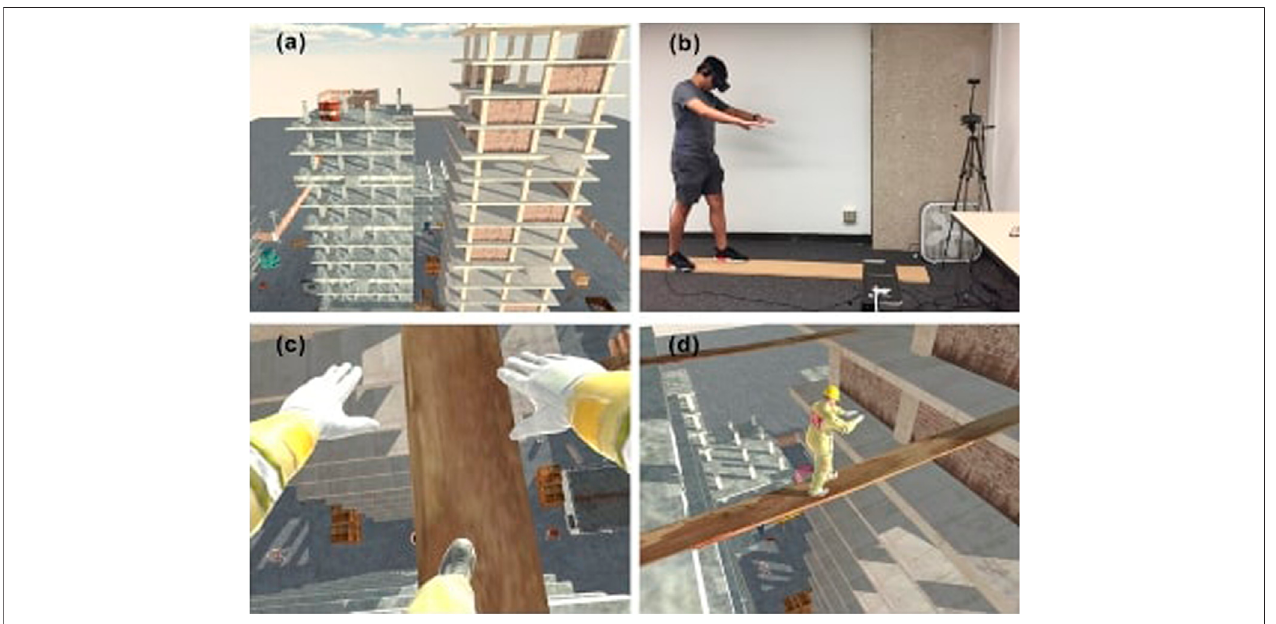
FIGURE 12 | Shi et al. (2019) highlighted that slight movement mismatches in the IVE when participants rotate their heads can affect their sense of presence. Shi et al. (2019) used real planks to provide haptic feedback while participants walked on “ virtual planks. ”